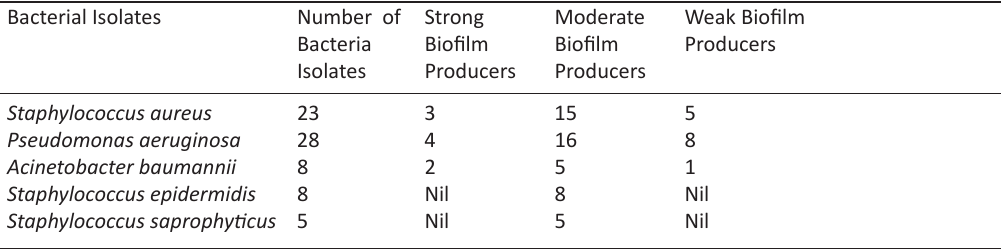
Table 1. biofilm production by clinical MDR bacterial isolates Bacterial